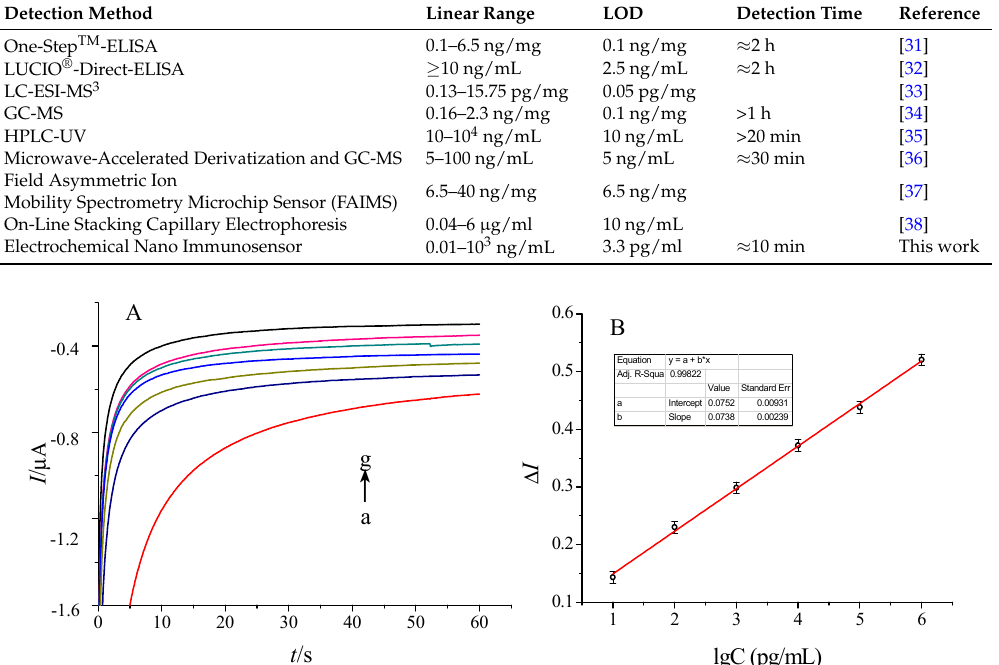
Figure 6. ( A ) Response curves of current for the determination of THC: a. 0.01 M pH 7.4 PBS buffer solution blank control; b~g are the multiple PBS buffer solution proportions diluted THC solution, the mass concentration is 0.01~10 3 ng/mL; ( B ) Linear response curve for the determination of THC.